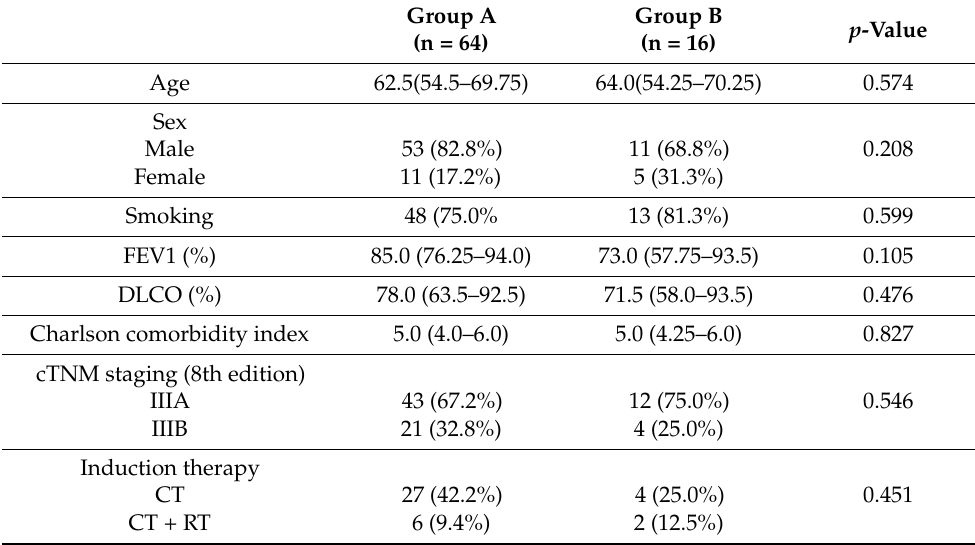
Table 1. General and perioperative characteristics of